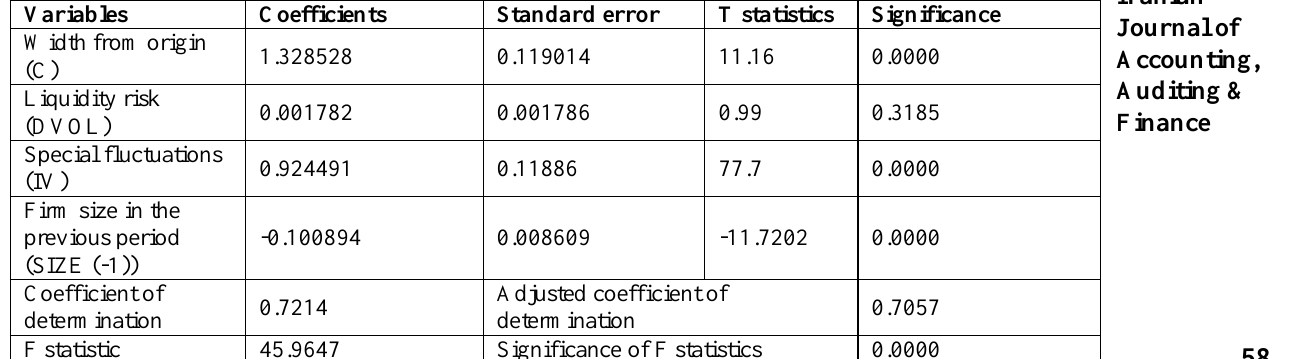
Table 6: Results of data analysis in order to test the second and third hypotheses